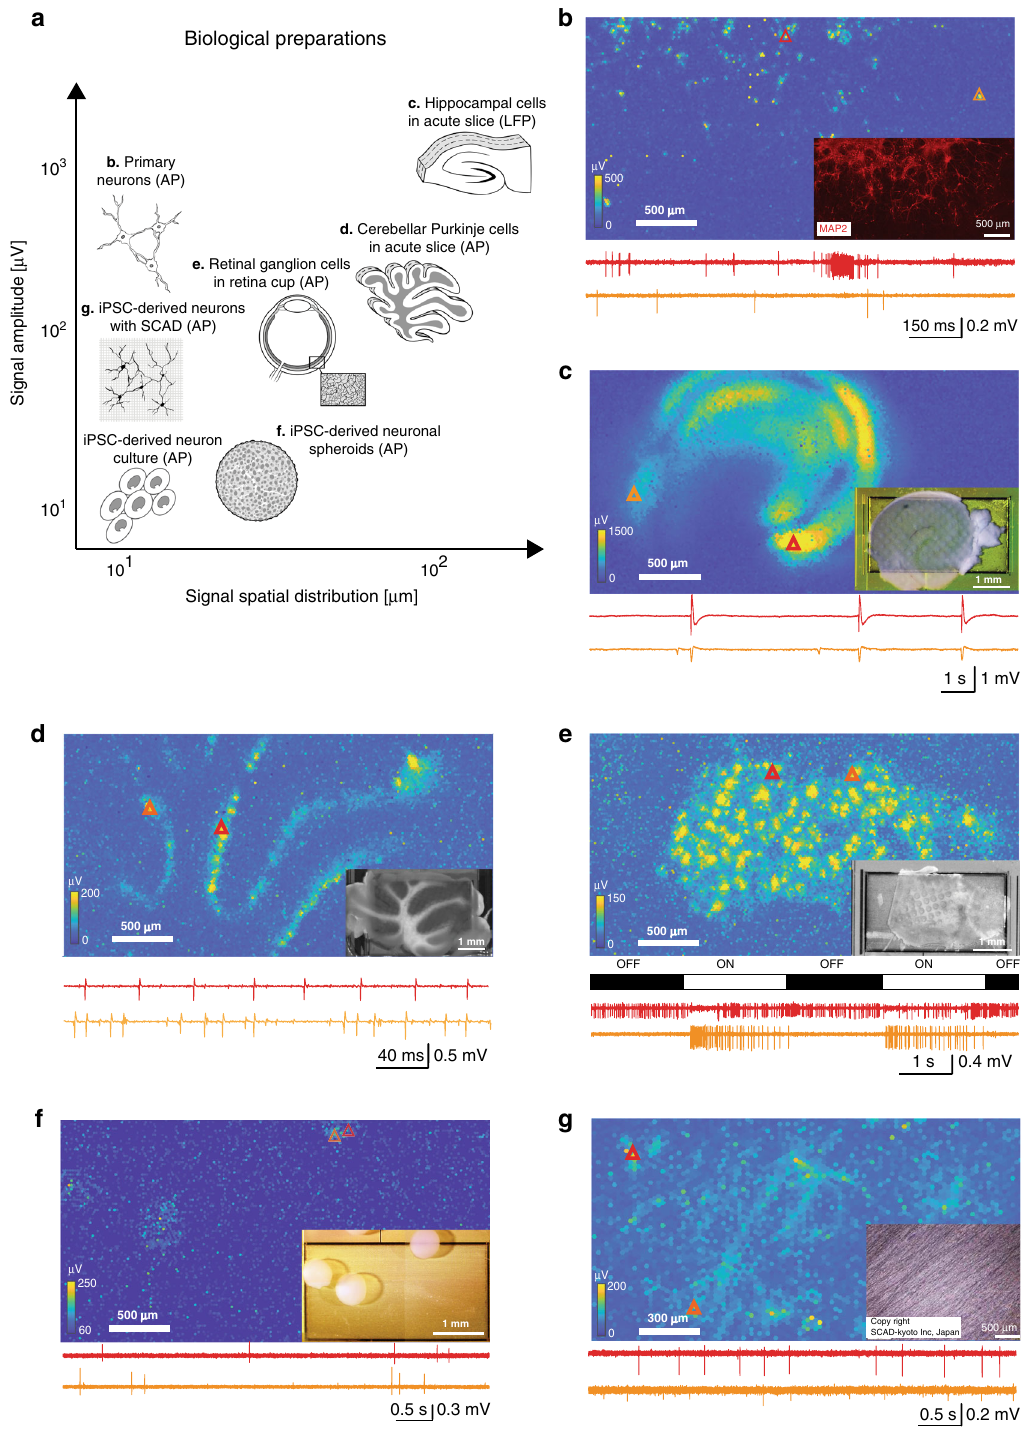
Fig. 3 Different biological preparations: optical images, electrical-activity maps, and example raw traces. The red and orange triangles mark the positions, where in each preparation the two exemplary signal traces have been recorded. a Summary of biological preparations shown in b – g , featuring different signal source spatial distributions and signal amplitudes (courtesy of MaxWell Biosystems AG). b Action-potential (AP) recording from primary rodent neurons. c Local- fi eld-potential (LFP) recording from acute hippocampal slices. d AP recording from acute cerebellar slices. e Recording from an acute retina preparation including light responses. f Recording from iPSC-derived neuronal spheroids. g Recording from iPSC-derived neurons using a SCAD scaffold device for 3D cell cultures (SCAD Kyoto Inc). For each preparation, more than three independent experiments (technical repetitions) were conducted, yielding comparable